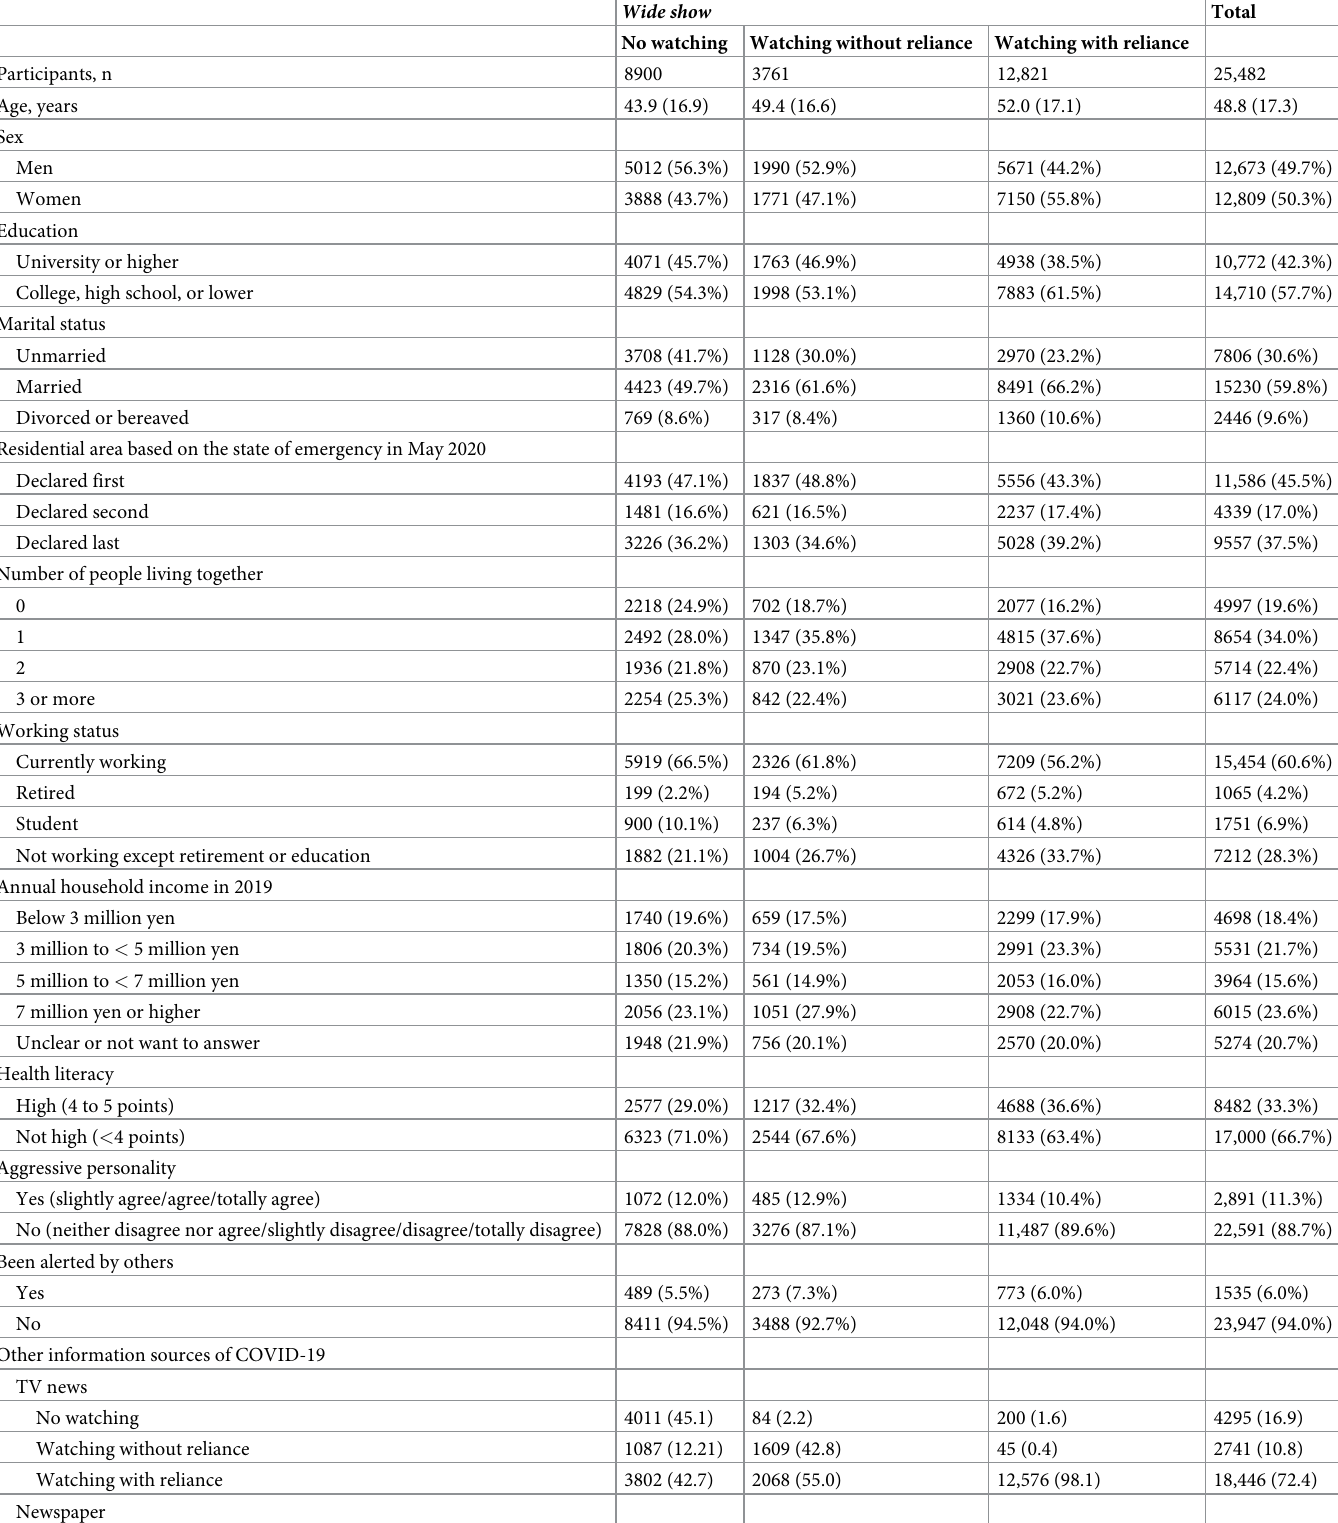
Table 1. Participants characteristics according to the status of watching wide show as a COVID-19 information